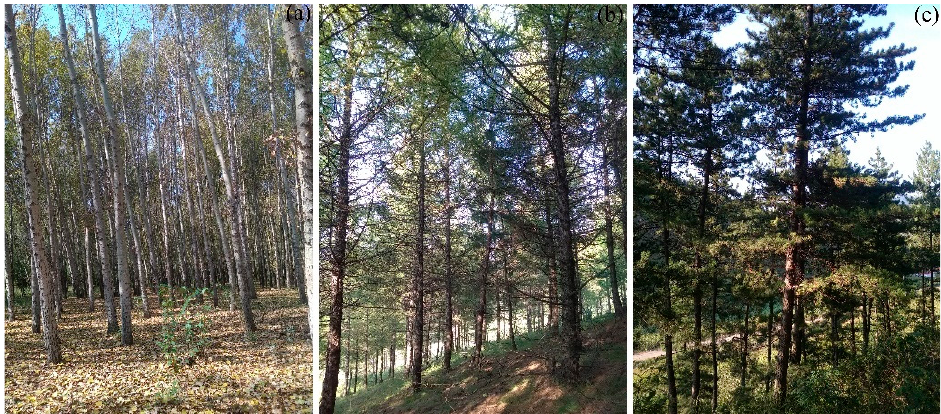
Figure 2. The pictures of the field survey of forest canopy closure in September 2019 in Chifeng city (( a – c ), respectively, refer to Populus spp., Larix spp., and Pinus tabulaeformis ).